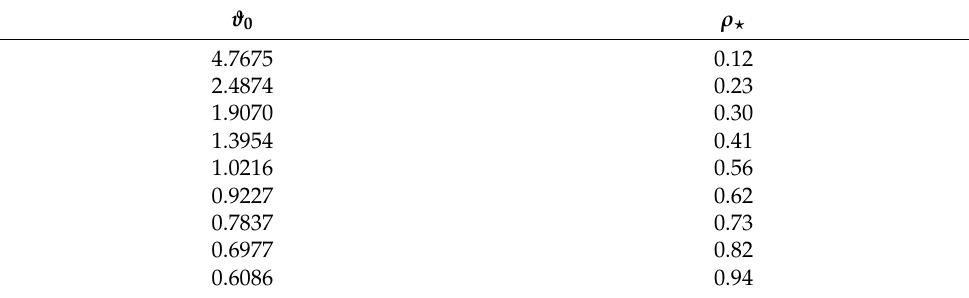
Table 2. The relation of ϑ 0 and ρ (cid:63) of system